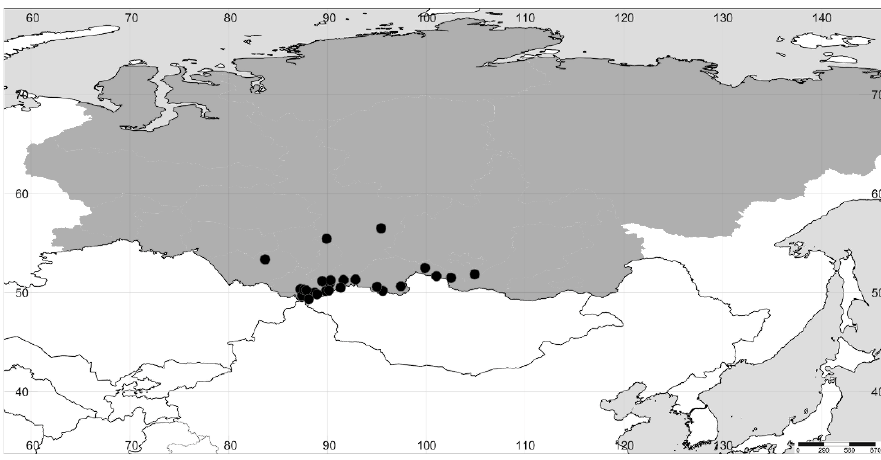
Figure 3. The distribution of A. prostrata in Siberia (the region itself is colored gray).